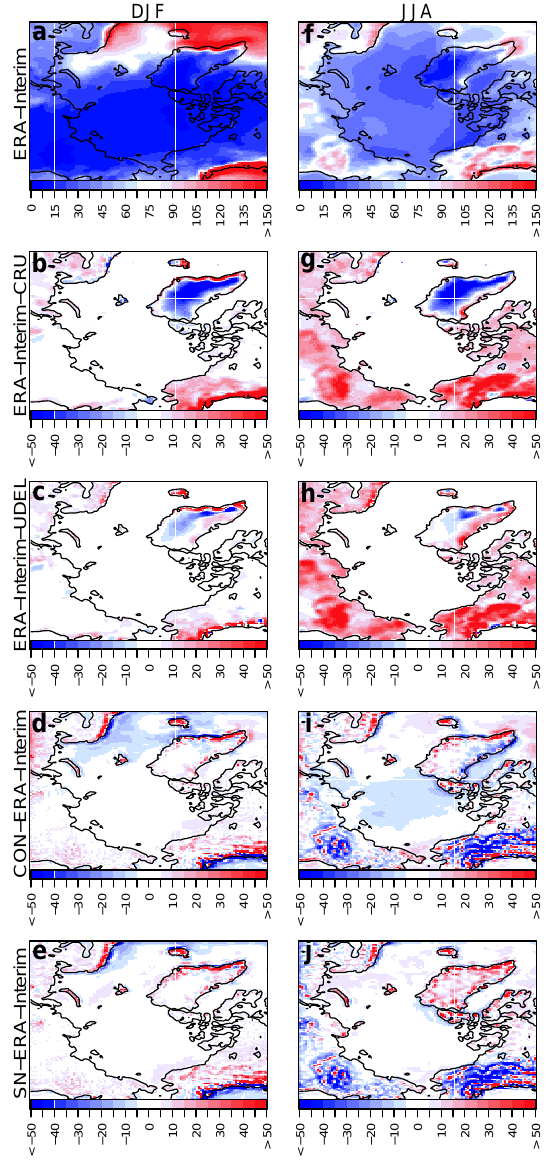
Fig. 9. Same as Fig. 8, but for precipitation in mmmonth − 1 . Note that also GPCC data were included in the analysis, with results very similar to the UDEL shown in the figure, and are therefore not shown.